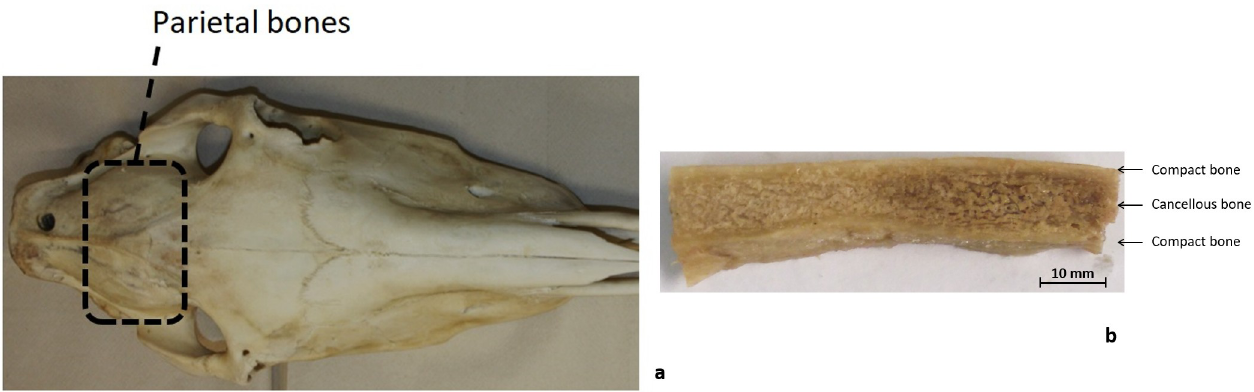
Fig 2. Sample extraction from equine heads. a) Dorsal view of horse head showing the location of the parietal bones b) Parietal bones beam-like sample.